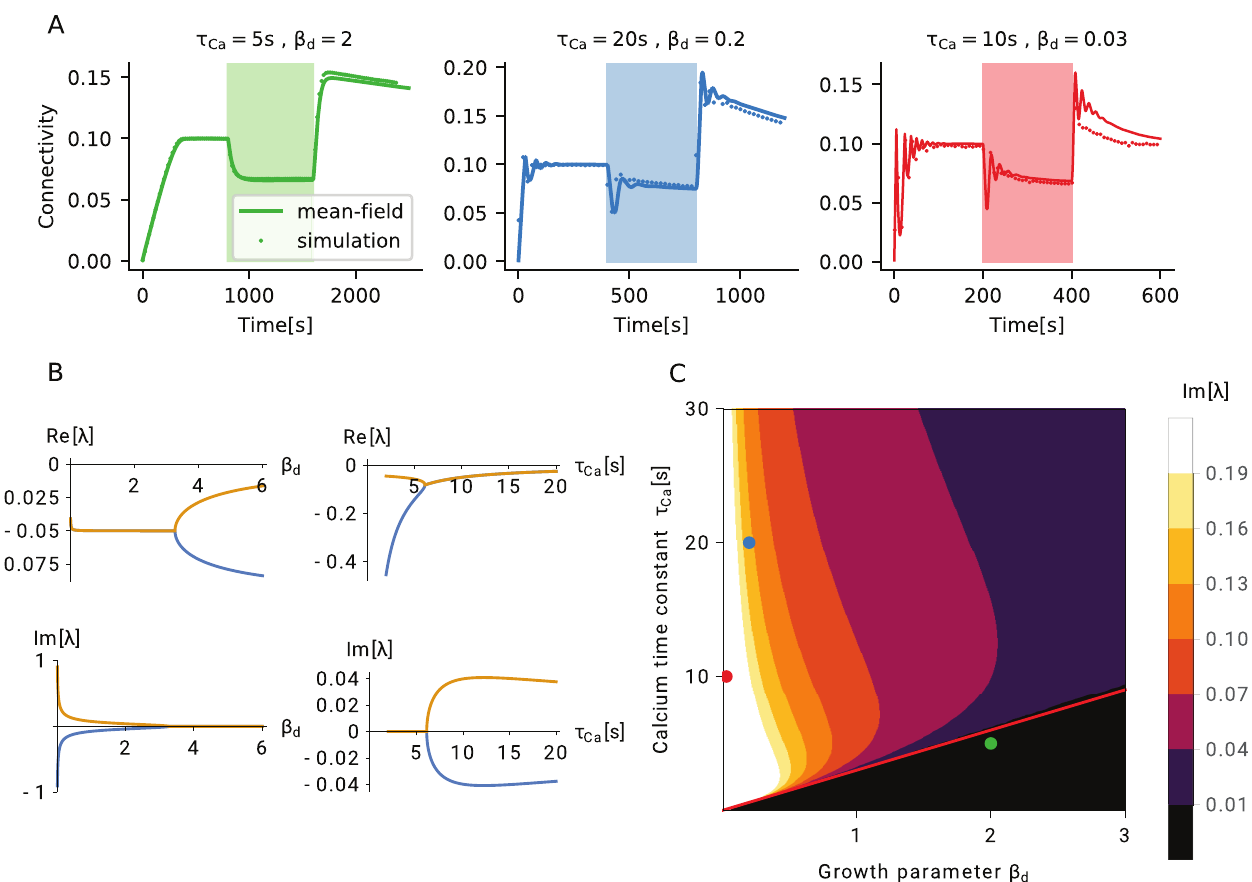
Fig 6. Linear stability of a network with homeostatic structural plasticity. (A) For a wide parameter regime, the structural evolution of the network has a single fixed point, which is also stable. Three typical types of homeostatic growth responses are depicted for this configuration: non-oscillatory (left), weakly oscillatory (middle), and strongly oscillatory (right) network remodeling. (B) All eigenvalues of the linearized system have a negative real part, for all values of the growth parameters of dendritic (axonal) elements β and calcium τ Ca . In the case of fast synaptic elements (small β ) or slow calcium (large τ Ca ), the system d d exhibits oscillatory responses. Shown are real parts and imaginary parts of the two “most unstable” eigenvalues, for different values of β d (left column, τ Ca = 10 s) and τ Ca (right column, β = 2). (C) Phase diagram of the linear response. The black region below the red line indicates non-oscillatory responses, which d corresponds to the configuration τ Ca � 3 β s. Dots indicate the parameter configurations shown in panel (A), with matching colors. d